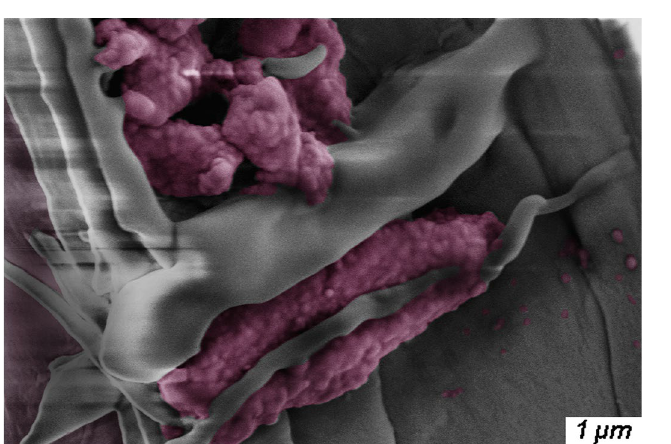
Figure 7. SEM images: pre-treated poplar specimens ( a , c ) and R-PTC specimens ( b , d ).